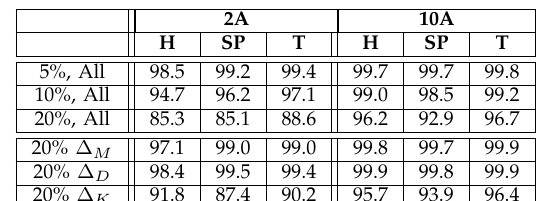
TABLE II: Worst-case electrical power capture for in- troduced modeling error for sea-state 2A and 10A in heave (H), coupled surge and pitch (SP), and the total (T)